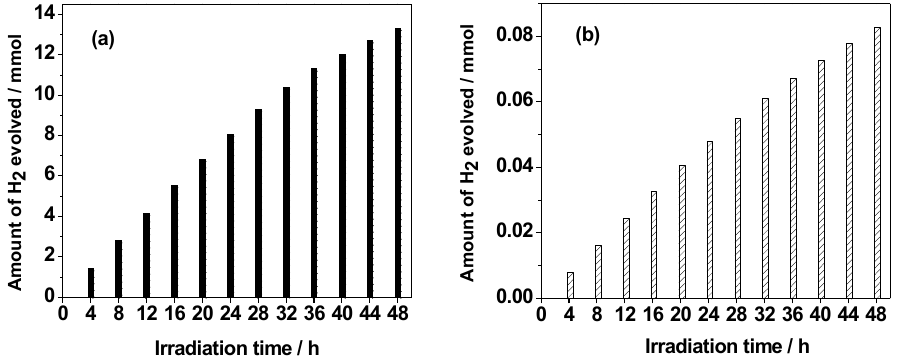
Figure 8. Time course of hydrogen evolution over 1.5% CuO ‐ SrTiO 3 ( a ) and pure SrTiO 3 ( b ). The amount of photocatalyst: 120 mg; the concentration of methanol: 60 mL, 60 vol.%; reaction temperature: 45 °C.